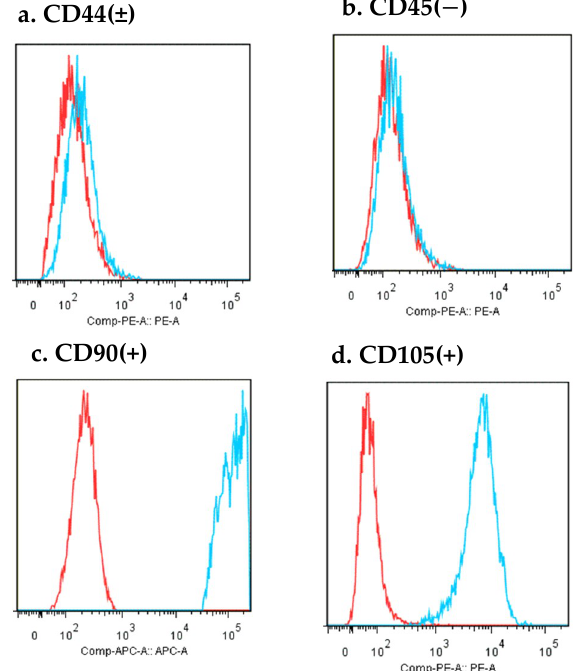
Figure 7. Flow cytometry results for the rat dedifferentiated fat cells, expressing cluster of differentiation ( a ) (CD)44, ( c ) CD90 and ( d ) CD105, but not ( b ) CD45. The red histogram represents the isotype control. The blue histogram represents the positive expression of the CD markers.